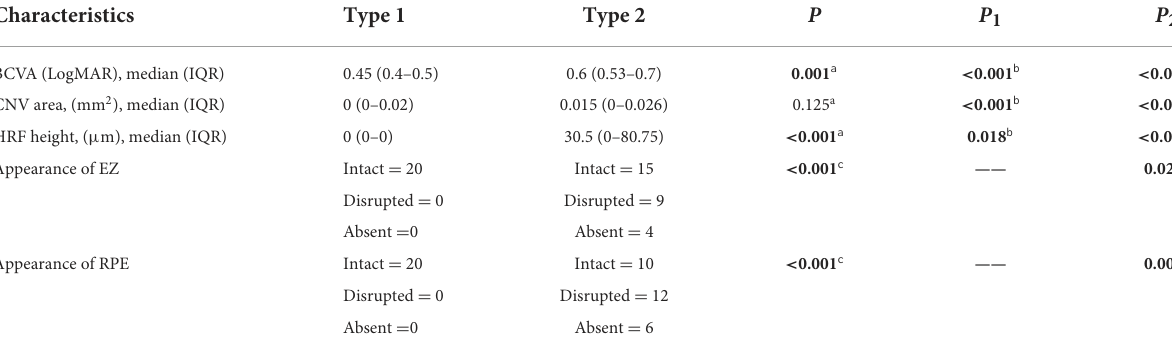
TABLE 3 Comparison of clinical characteristics after anti-VEGF Treatment with